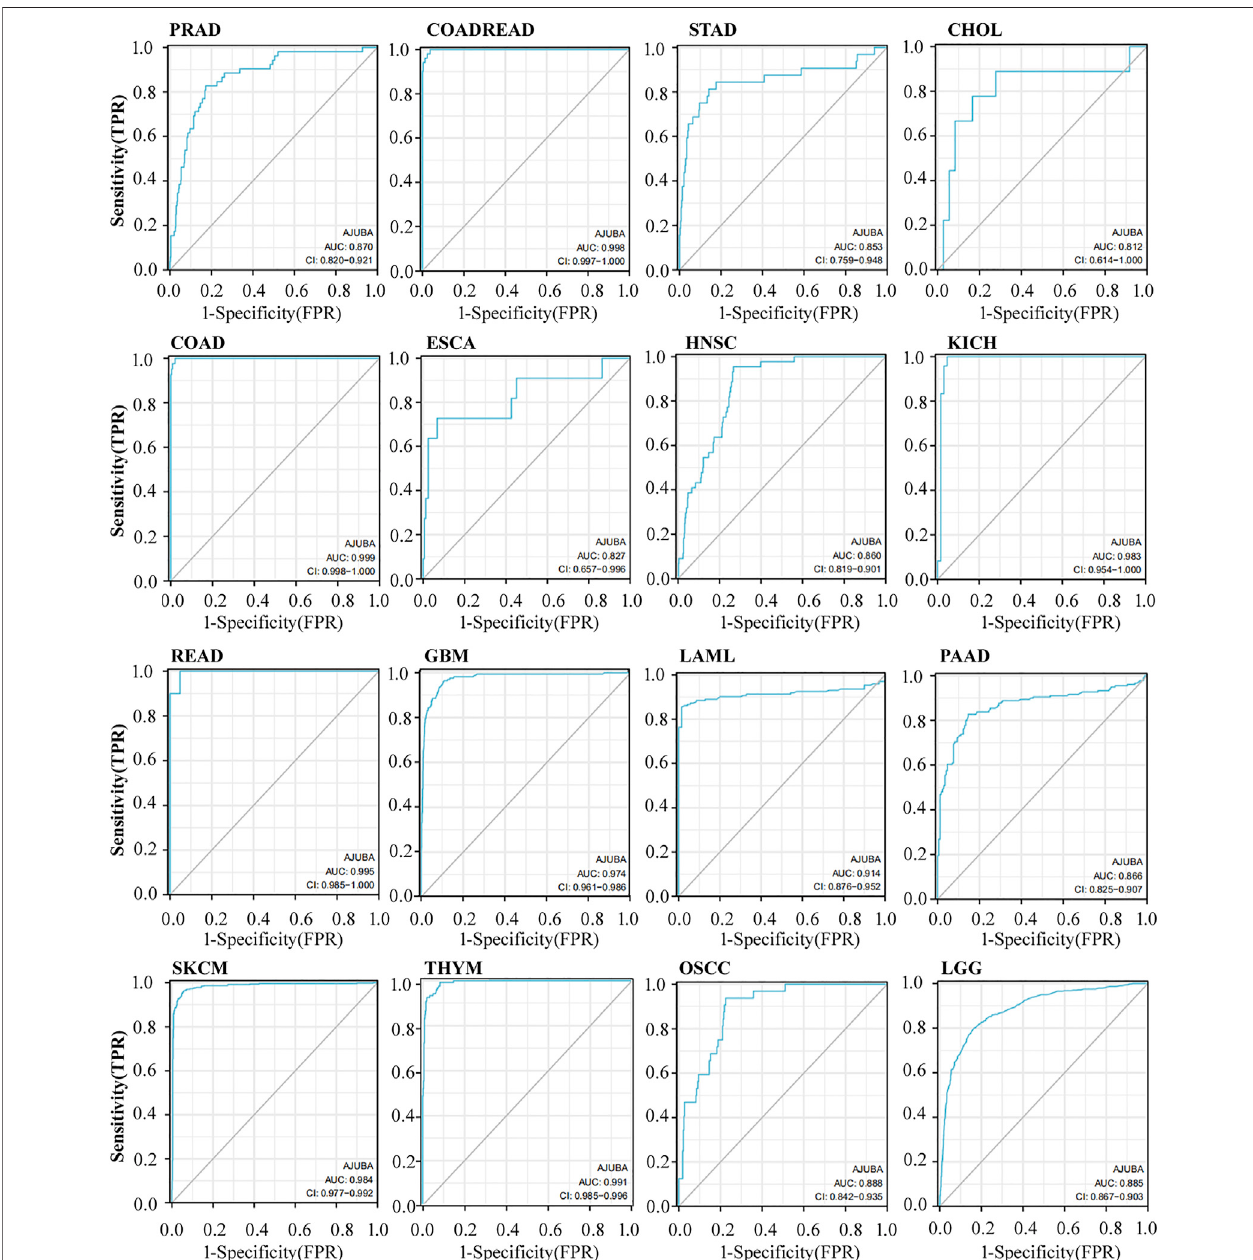
FIGURE 4 | The diagnostic value of AJUBA in different cancers, including prostate adenocarcinoma (PRAD), colon and rectal adenocarcinomas (COADREAD), STAD, CHOL, COAD, esophageal squamous cell carcinoma (ESCA), head and neck squamous cell carcinoma (HNSC), kidney chromophobe (KICH), rectum adenocarcinoma(READ),glioblastomamultiforme(GBM),acutemyeloidleukemia(LAML),pancreaticadenocarcinoma(PAAD),SKCM,andthymoma(THYM),aswellas oral squamous cell carcinoma (OSCC) and LGG.